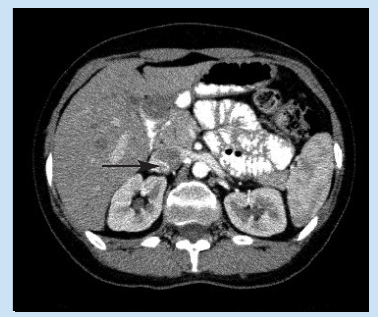
Fig. 9. Unopacified hepatic veins appearing as hypodense lesions. Note the heterogeneous enhancement of the spleen.